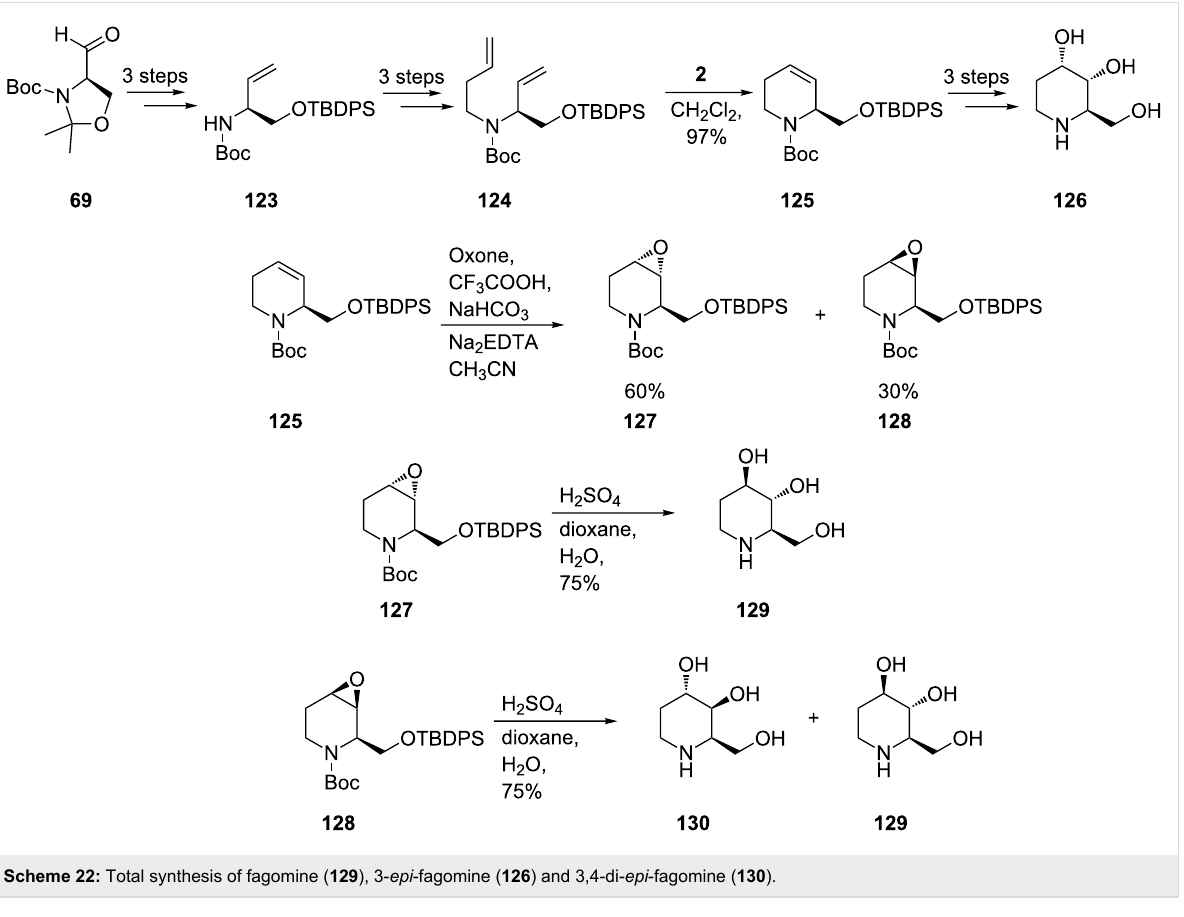
Scheme 22: Total synthesis of fagomine ( 129 ), 3- epi -fagomine ( 126 ) and 3,4-di- epi -fagomine ( 130 ).